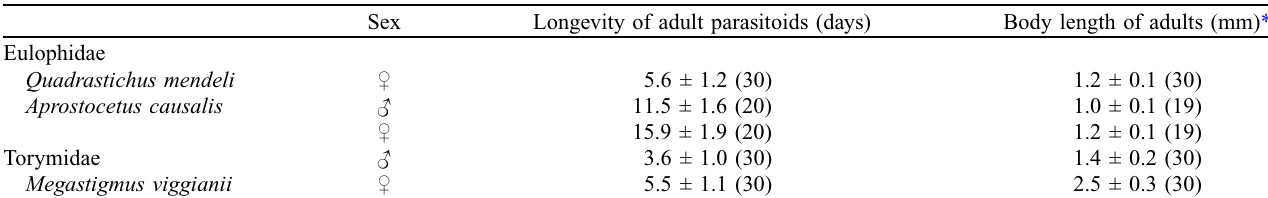
Table 2. Longevities and body lengths of Quadrastichus mendeli , Aprostocetus causalis , and Megastigmus viggianii